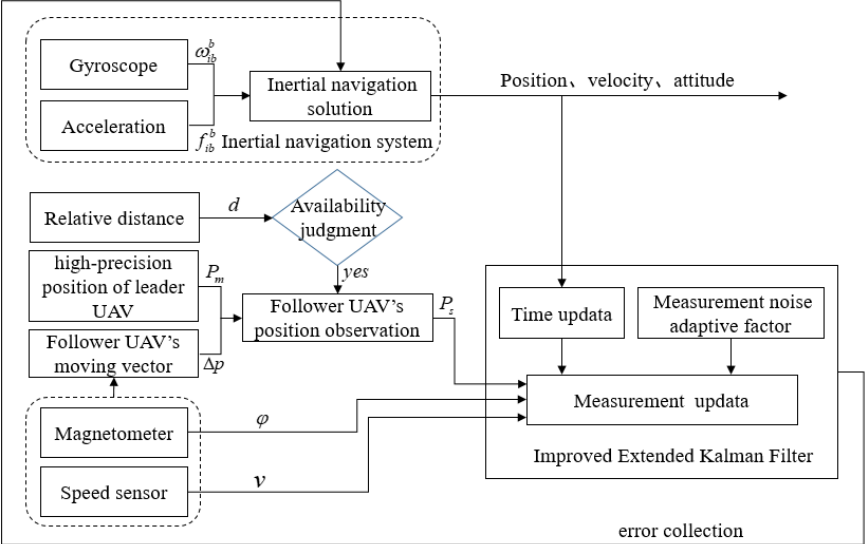
Figure 2. The schematic diagram of proposed method in this